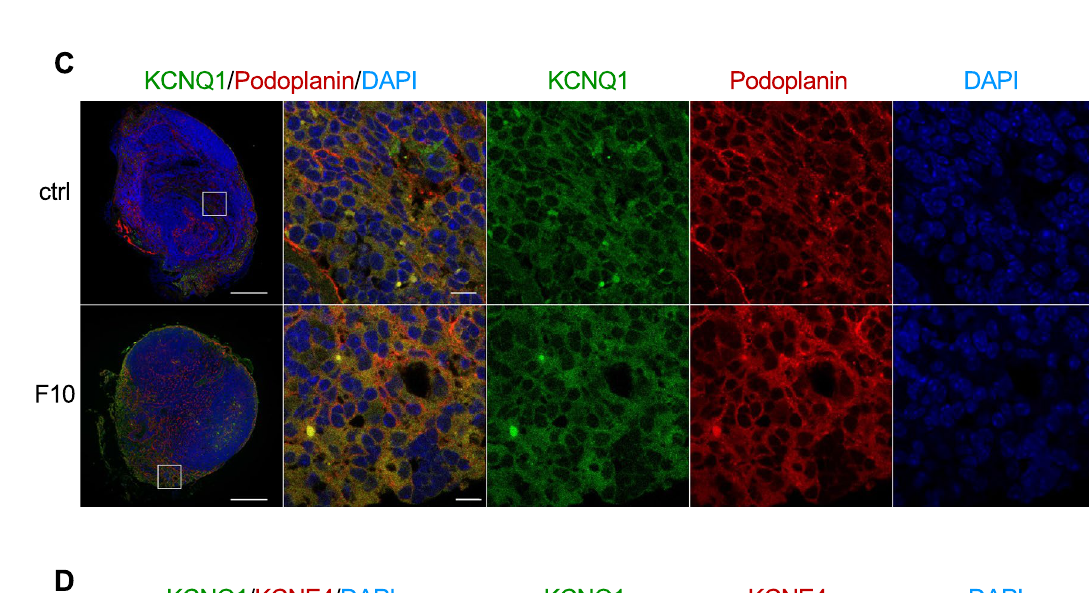
metastasis model, was also expressed in human lymph node tissues to which melanoma had metastasized. As shown in Fig. 6, KCNE4 was detected in human LNs with metastasis, and the podoplanin-positive areas were KCNE4-positive.